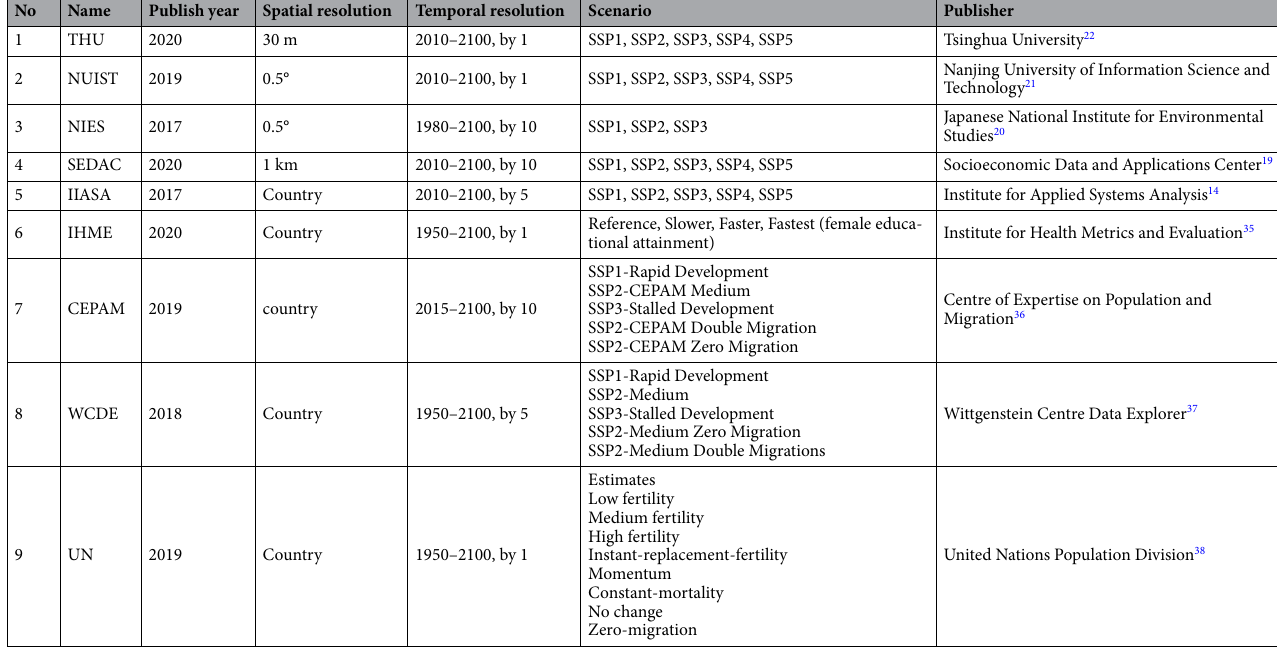
Table 1. Population data